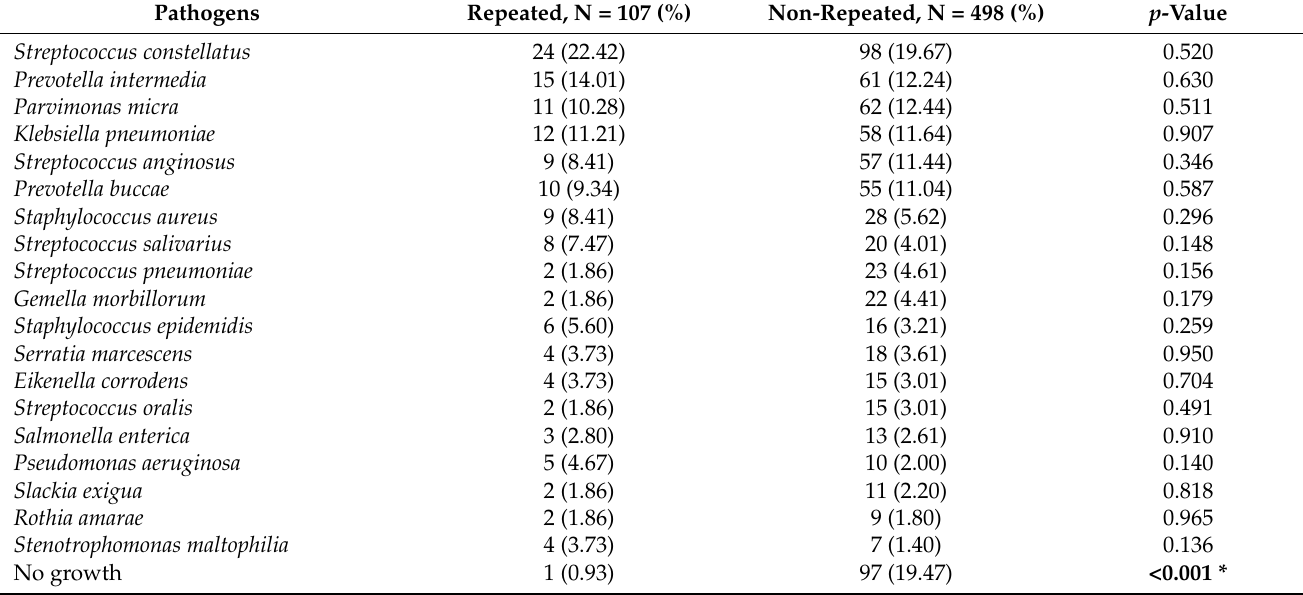
Table 4. Pathogens concerning 107 patients who required repeat I&D and 498 patients who did